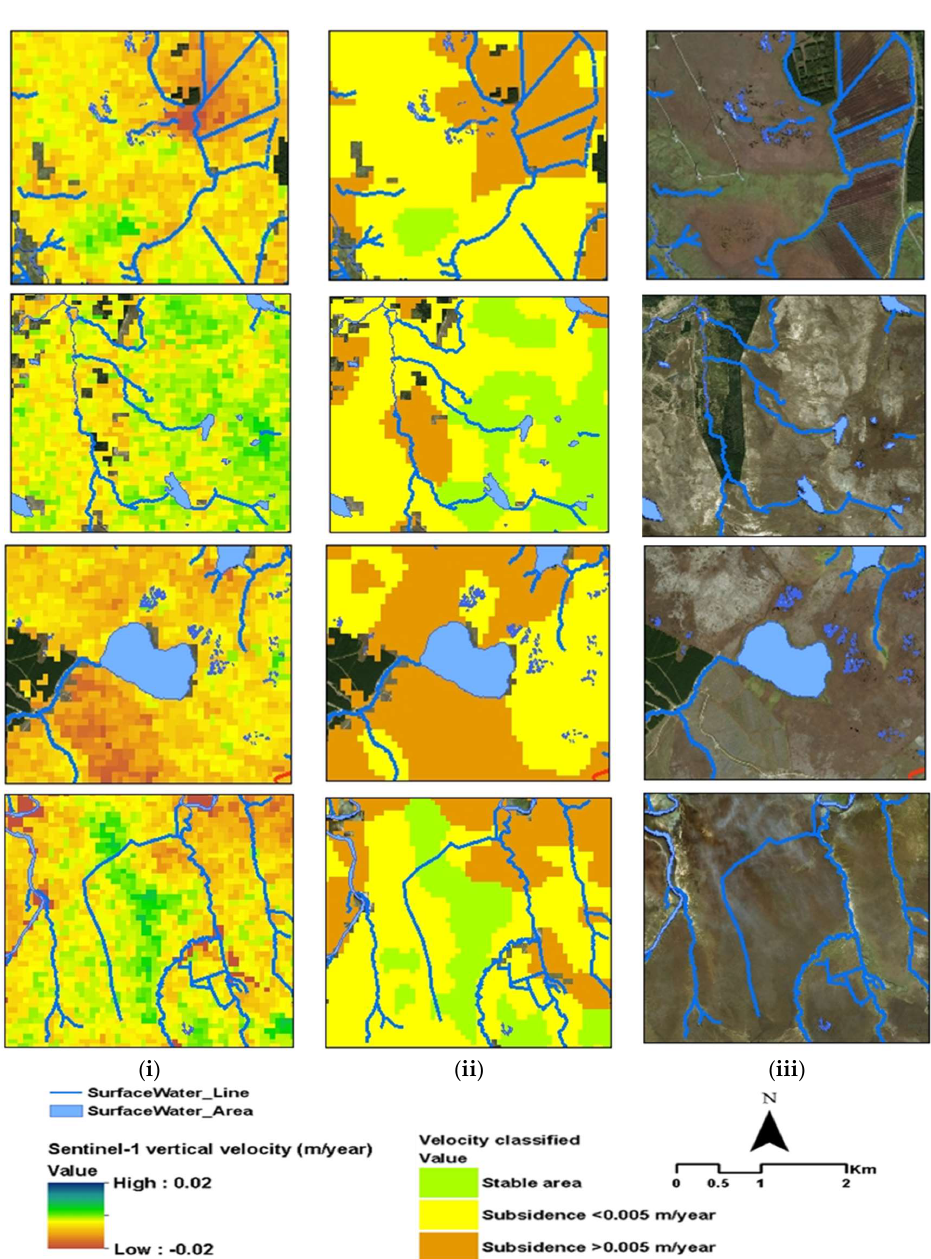
Figure 8. Sentinel-1 ISBAS vertical velocity (m/year) maps ( i ) along with their outputs having undergone unsupervised segmentation ( ii ) to illustrate three main classes of (stable areas, subsidence at rates less than 0.005 m/year and subsidence at rates of more than 0.005 m/year. Corresponding Google Earth VHR imagery ( iii ) to aid interpretation over the same area for four different locations (from top to bottom): Flow Country; Bowside Lodge Loch; Sletill and South Westerdale.